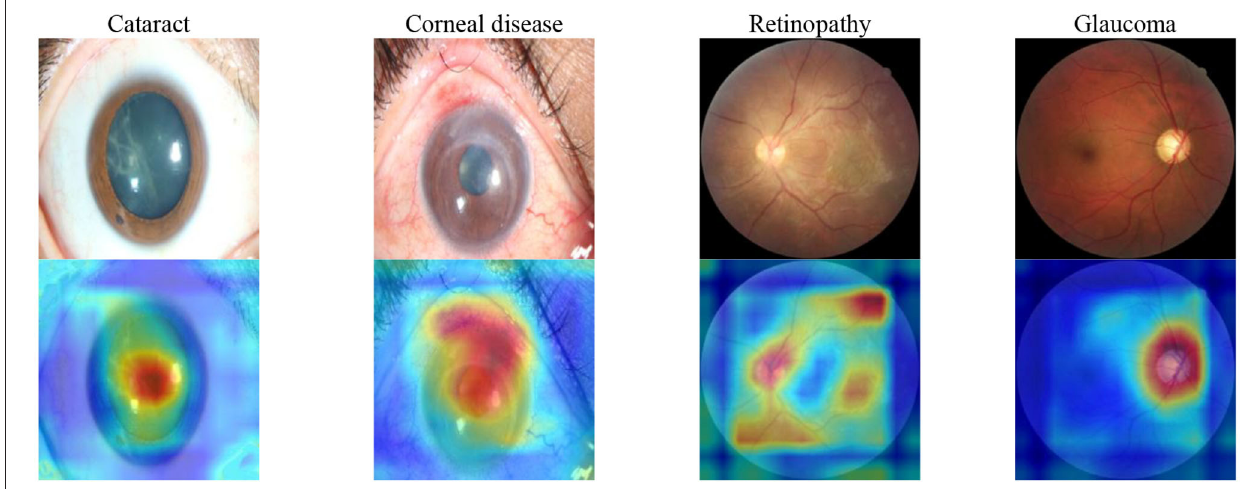
FIGURE 8 | Saliency maps for images with various common visual impairment diseases. These visualizations are generated automatically, locating regions for closer examination after a patient is seen by a consultant ophthalmologist. The bluer the color, the lower the attention of the model; the redder the color, the higher the attention of the model. Visualization maps are generated from deep learning